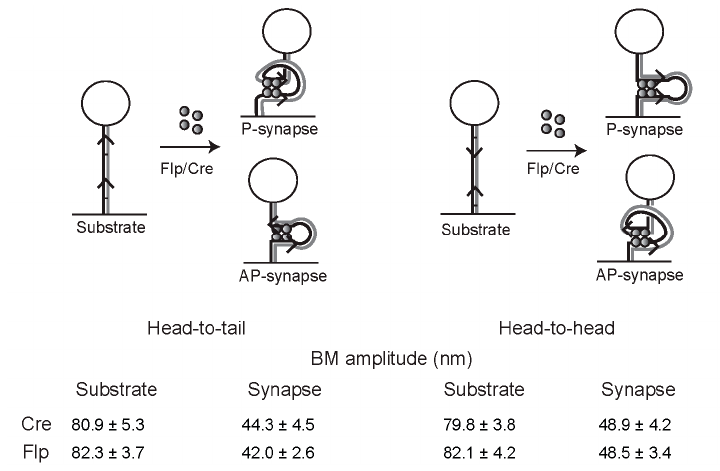
Figure 8. Geometry of target site alignment within the tyrosine recombination synapse inferred from TPM. The schematic diagram illustrates the configurations of the DNA tether when the recombinase-bound sites align themselves in parallel (P) or anti-parallel (AP) geometry within the planar recombination synapse. The head-to-tail (deletion) and head-to-head (inversion) substrates, and their synapsed states, are shown in the left and right panels, respectively. The mean BM amplitudes, tabulated below, are from the TPM analyses of the tyrosine recombinases Cre and Flp. There is a small, but significant increase in the BM amplitude of synapsed head-to-head sites when compared with head-to-tail sites for both Cre and Flp. The higher value is consistent with anti-parallel synapse, as the DNA tether is expected to experience a lower constraint when it enters and exits the synapse from opposite ends, rather than from the same end. This inferred synapse geometry conforms to evidence from other analyses, and is complied within the schematic diagrams in Figures 3–5.